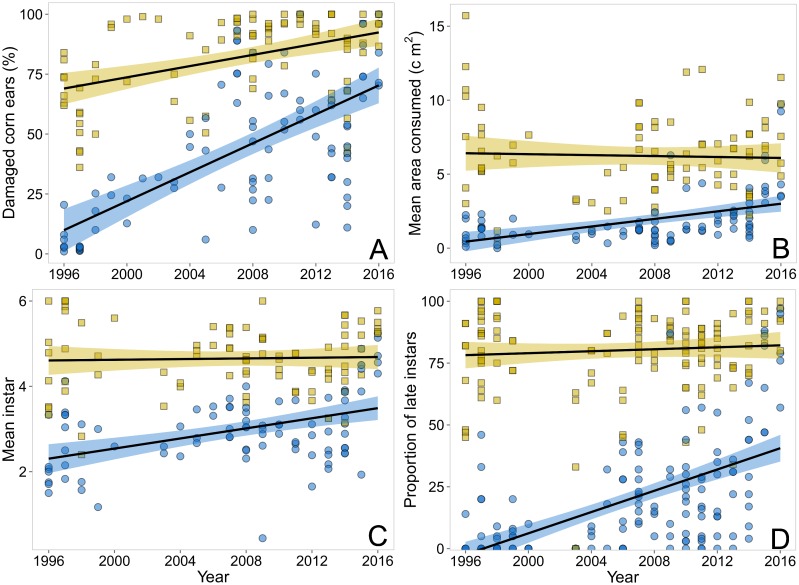
Trends comparing efficacy of Cry1Ab Bt sweet corn (Attribute) with non-Bt isogenic hybrids for control of Helicoverpa zea during 1996–2016 in Maryland, USA.Over years, Bt hybrids (blue circles and shades) had significant increases in the percentage of H. zea damaged ears (A), kernel consumption (B), instar stage (C) and proportion of late instars (D) than non-Bt hybrids (yellow squares and shades). Points represent the raw data, black lines represent the predictions from LMMs, while shaded region denote the upper and lower confidence levels (95% CI).